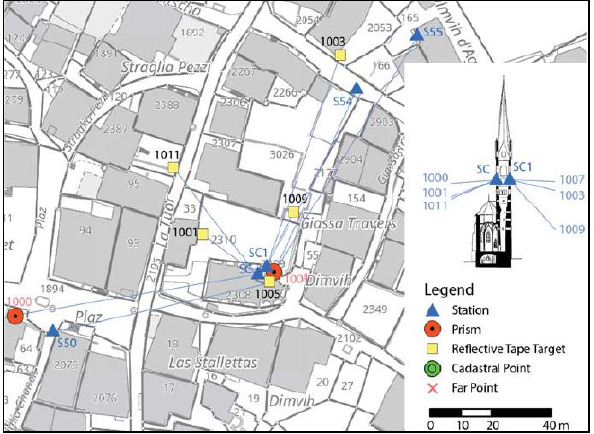
Figure 5. Network “Dorf”, measurements inside the bell tower of the C-floor on the map and on the side view of the tower